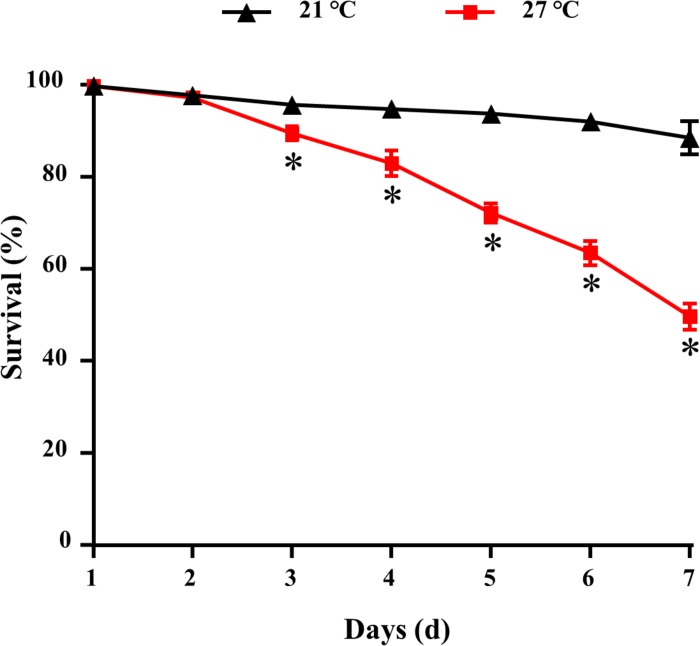
Survival for M. galloprovincialis. ∗P < 0.05.